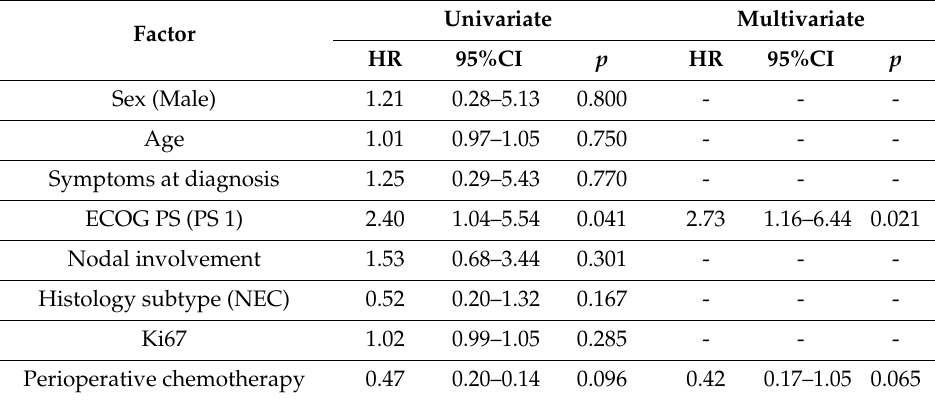
Table 3. Cox proportional hazard models for the risk of disease relapse or death.